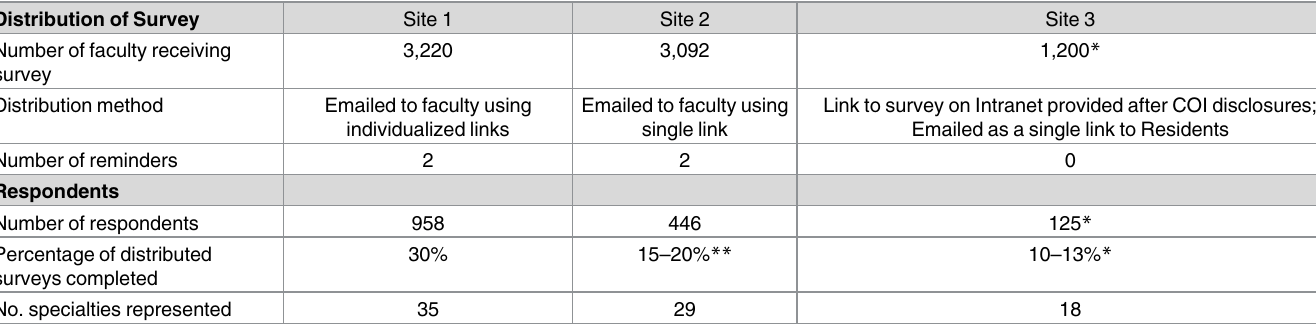
Table 2. COI survey distribution and